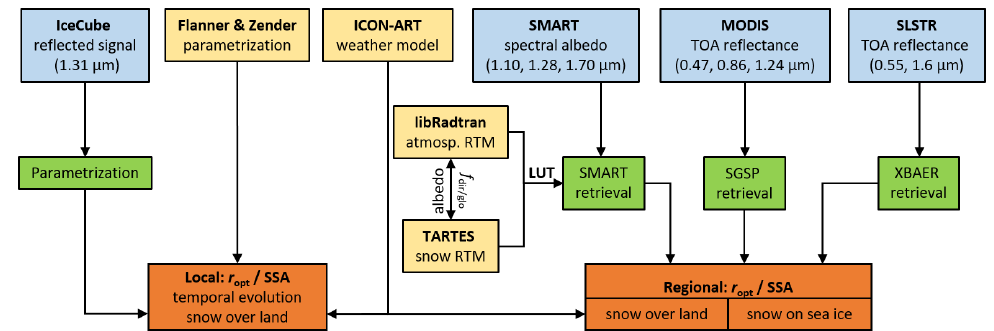
Figure 2. Schematics of the linkages between the different observational (blue boxes), retrieval (green boxes), and modeling (yellow boxes) methods used in this study. Details are given in the subsequent